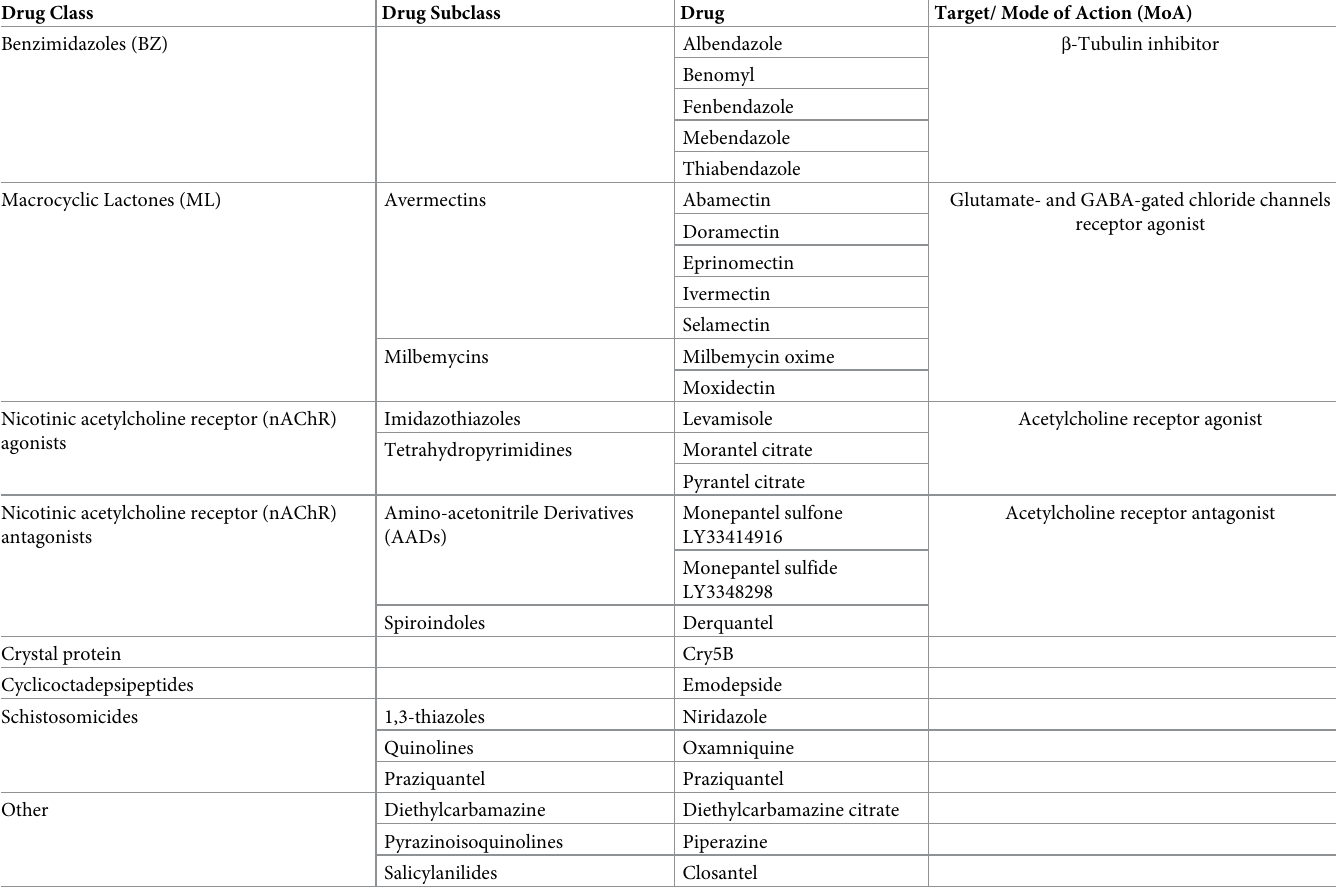
Table 1. Drug class, subclass, and drugs used in this study. Drug classes with defined Mode of Action (MoA) are